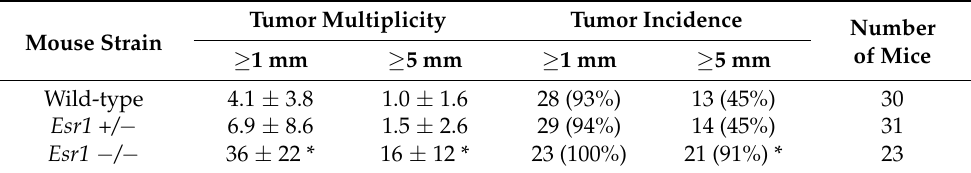
Table 1. Effect of Estrogen Receptor- α on liver tumor multiplicity and incidence in females.